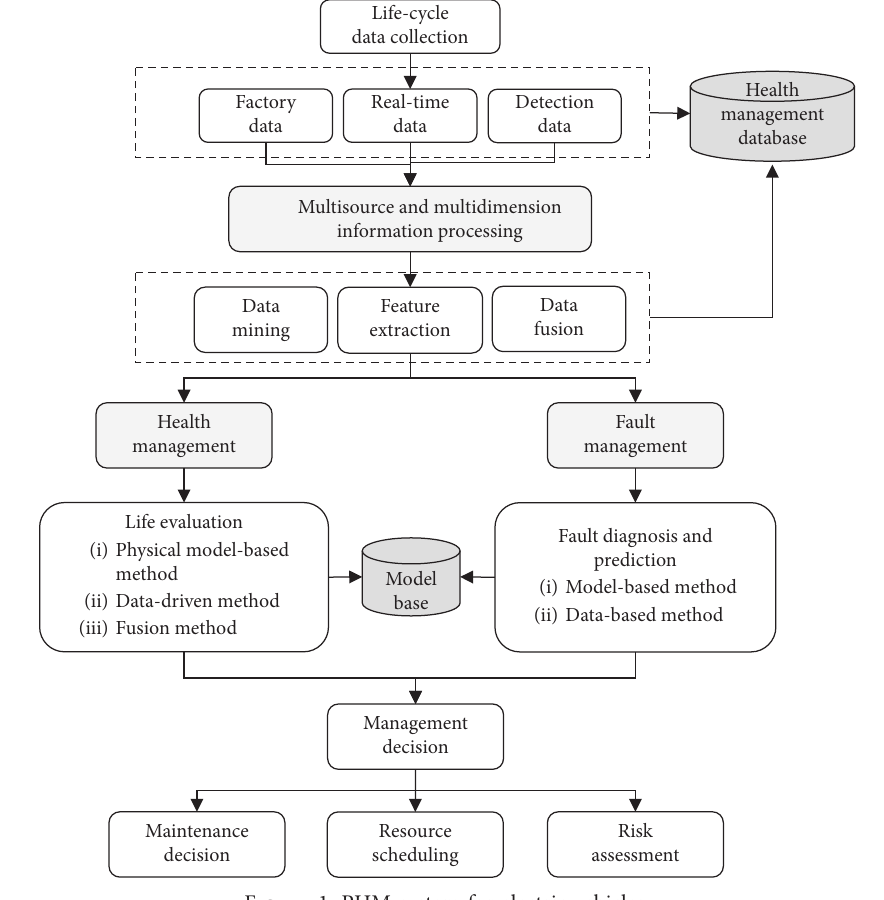
Figure 1: PHM system for electric vehicles.